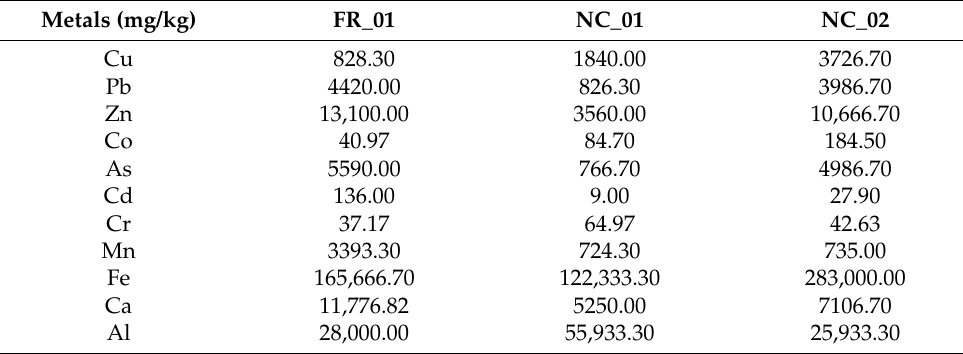
Table 1. Total element concentrations of the three mine waste